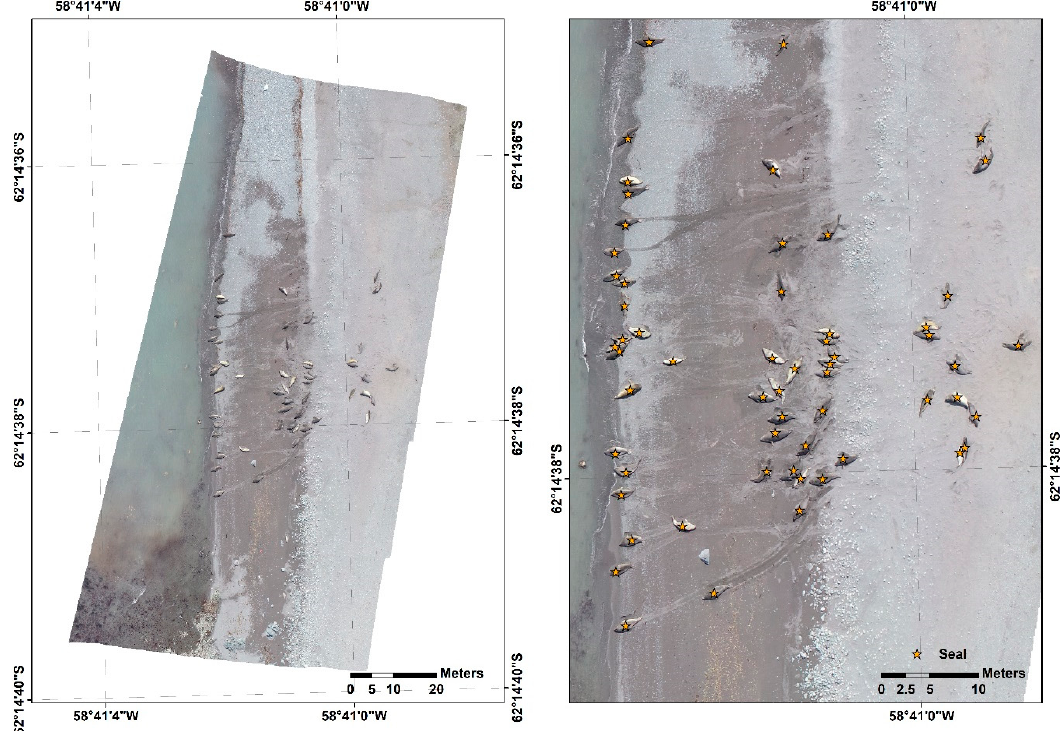
Figure 3. Mosaicked RPAS-based RGB images for identifying the status of Southern elephant seals ( Mirounga leonina ) in Potter Peninsula, King George Island, Antarctica.